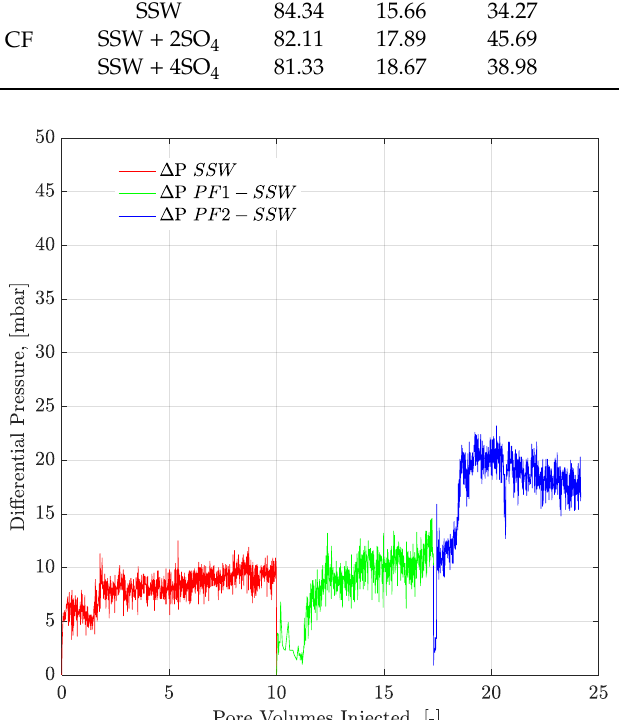
Figure 17. Pressure drop versus PV injected for complex-wet micromodel. PF1 (polymer half to the oil viscosity) and PF2 (polymer equal to the oil viscosity) flooding after the brine flood in secondary mode. ΔP SSW + 2SO 4 represents the pressure drop for synthetic seawater with doubled amount of sulfate. ΔP PF1-SSW + 2SO 4 represents the pressure drop of polymer injection having viscosity half to the oil and ΔP PF2-SSW + 2SO 4 shows pressure drop of polymer injection having viscosity equal to the oil. 3.7.2. Three-Weeks Aged Core Plugs Figure 18 presents pressure profiles for tertiary-mode polymer flooding in three-week aged cores. Polymer solutions with half the viscosity of oil were selected for tertiary-mode injection. Looking at the RF of polymer floods for three-week aged core plugs in Table 7, 2.7% more oil was